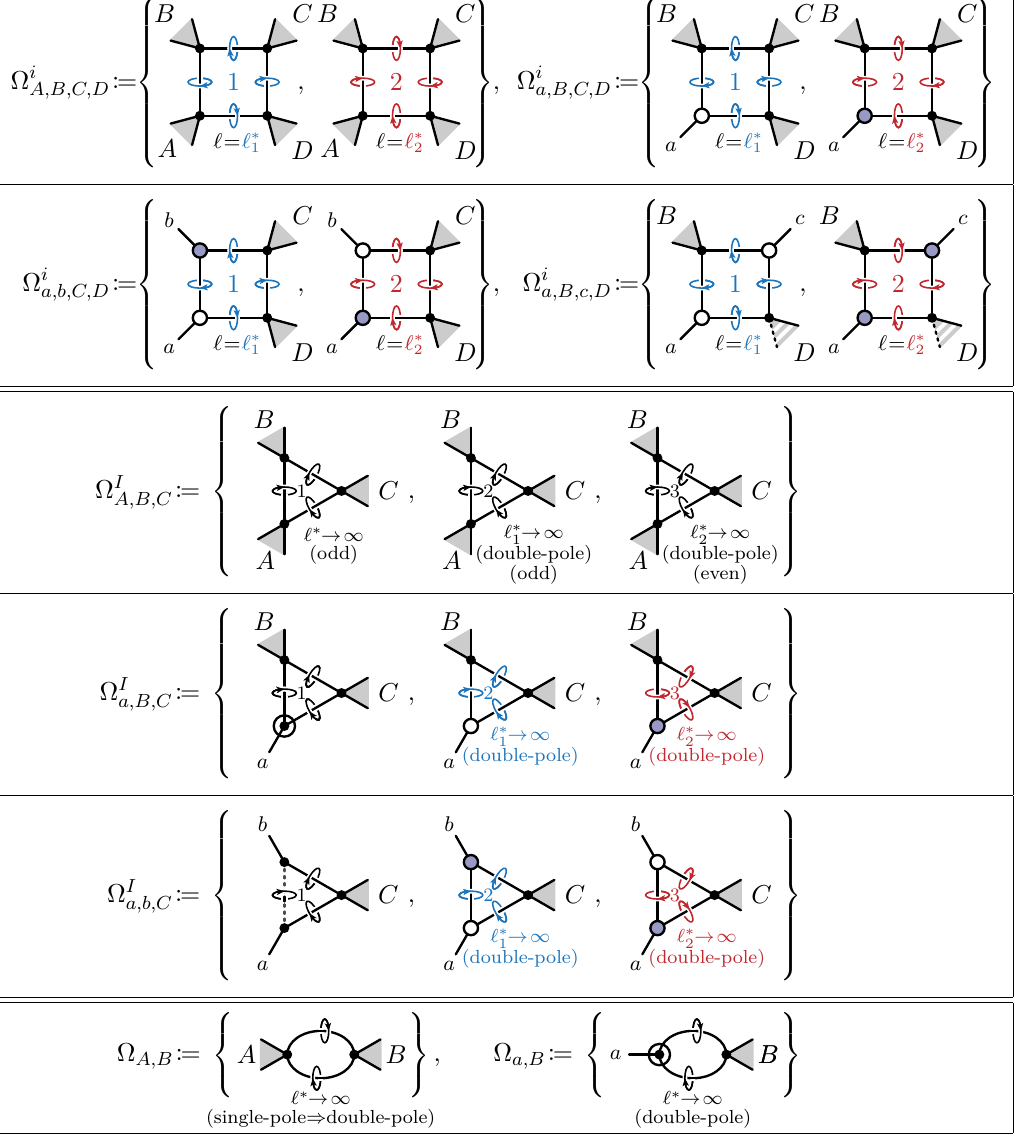
Table 3 . A complete specification of contours to which the integrand basis B (4)